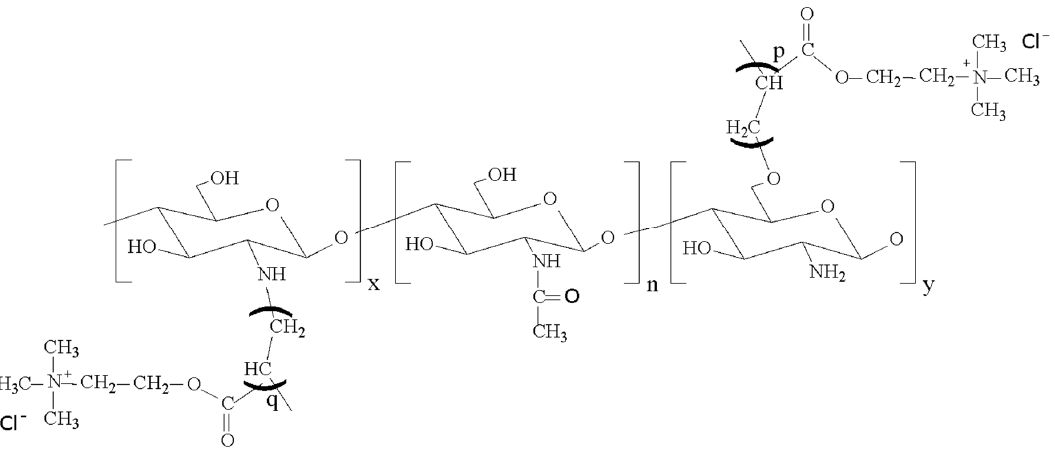
Figure 1. Chemical structure of QCS.